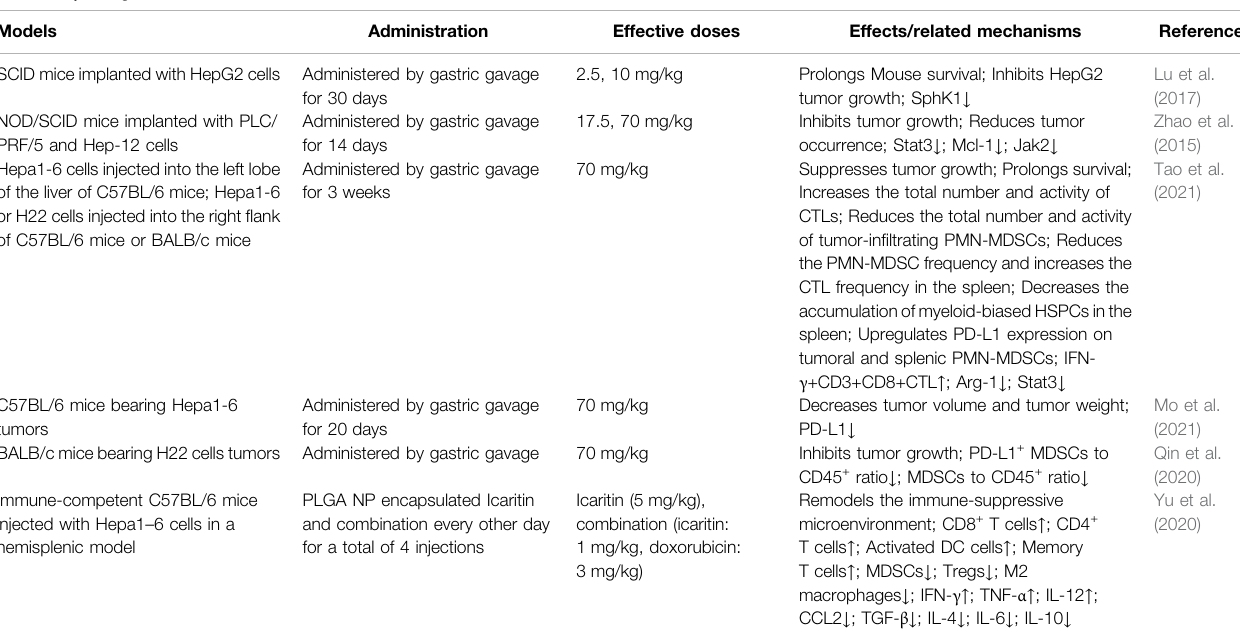
TABLE 5 | Biological effects of icaritin on in vivo models of